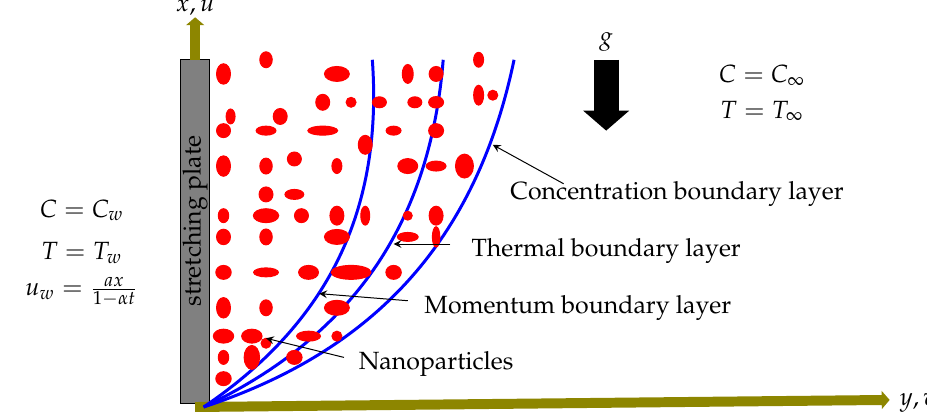
Figure 1. Schematic flow diagram and coordinate